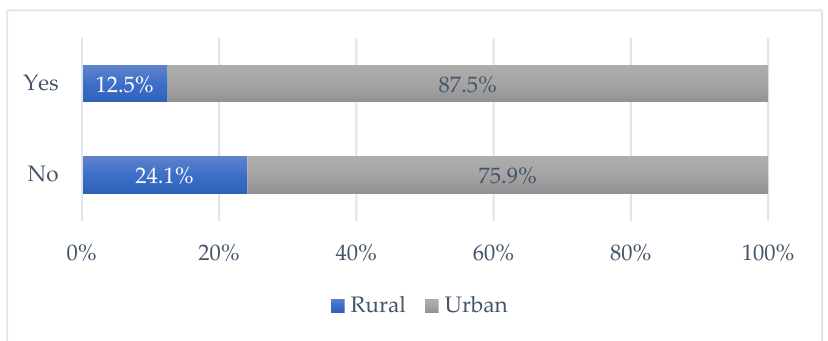
Figure 2. Place of residence and decision to vaccinate.